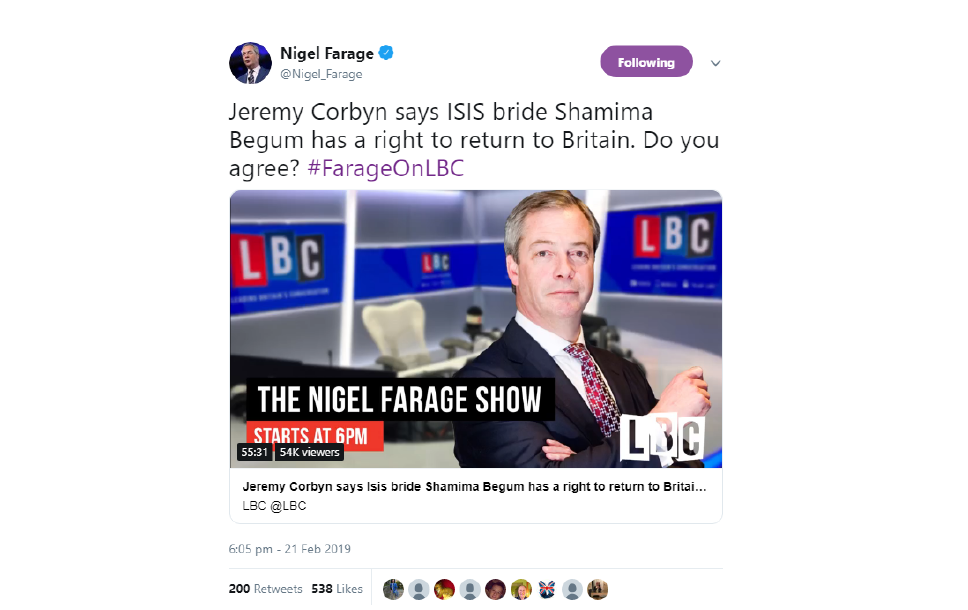
Figure 10. Tweet from Brexit Party leader Nigel Farage, 21 February 2019.